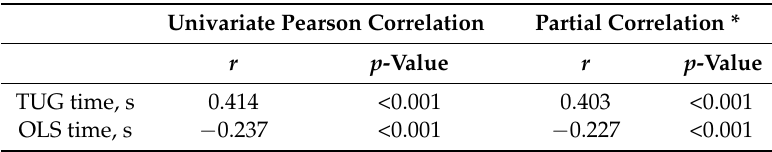
Table 3. Correlation analysis of KDSQ-C and TUG and OLS